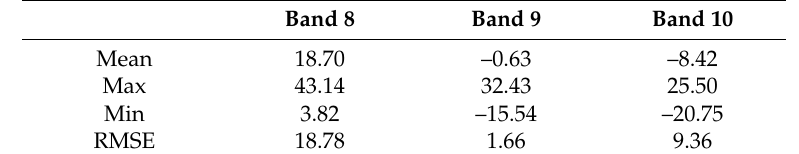
Figure 13. The joint probability distribution (PDF) of the simulated and observed brightness temperatures of (a) Band 8, (b) Band 9 and (c) Band 10 in July 2016; more than seven million pixels are included. Units are ‰. Table 3. Mean value, maximum value, minimum value and root mean square error of the absolute errors (simulations–observations) of three WV bands in July 2016. Units are K.